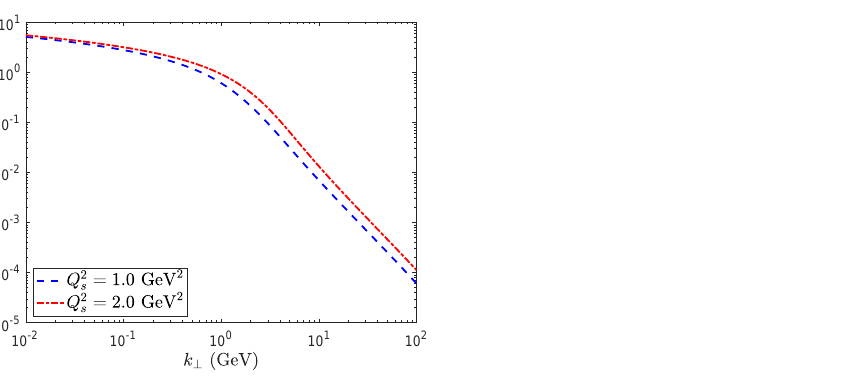
for two different values of the saturation ⊥ Q s . The x ⊥ ∼